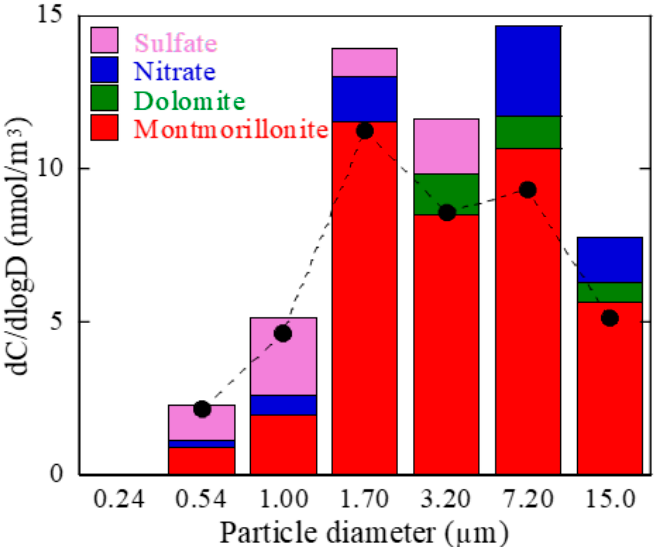
Figure 8. Speciation of Mg in aerosols determined by XANES analyses. Concentration of nss-Mg was also plotted as black circles.